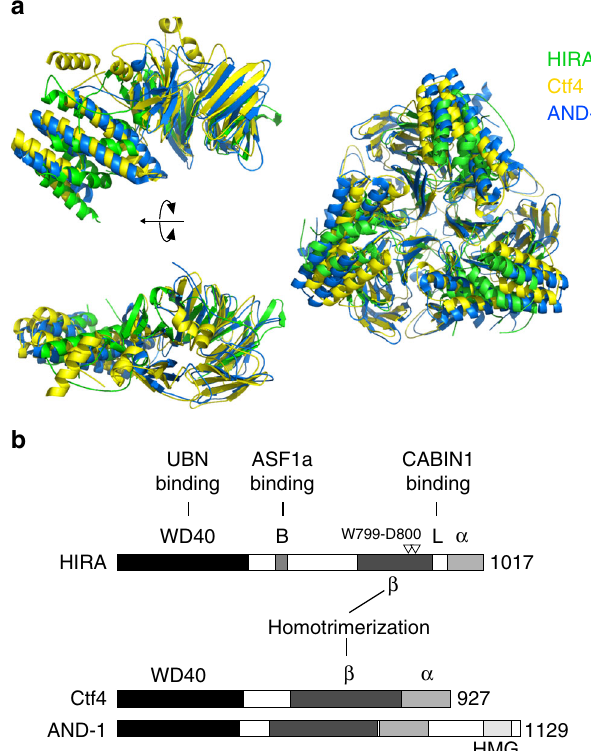
Fig. 5 Homotrimeric HIRA(644 – 1017) exhibits structural homology with the homotrimeric replisome factor Ctf4/AND-1. a (Left) Superpositions of the HIRA(644 – 1017) monomer (green) onto Ctf4 (yellow) and AND-1 (blue) monomers. These superpositions with Ctf4 and AND-1 give RMSDs values of 3.9 and 4.1 Å for 197 and 204 C α atoms, respectively. (Right) Superpositions of the HIRA(644 – 1017) trimer onto Ctf4 (RMSD = 4.6 Å with 620 C α atoms) and AND-1 (RMSD = 4.2 Å with 629 C α atoms) trimers. These superpositions were performed using the program SUPERPOSE in CCP4 49 . b Scheme of the predicted secondary structures of human HIRA, yeast Ctf4, and its human counterpart AND-1. They exhibit similarities, with a β -strand domain involved in the homotrimerization of the proteins, an α -helical domain in the C-terminus, and a WD40-repeat region in the N-terminus. The amino acids W799 – D800 found critical for